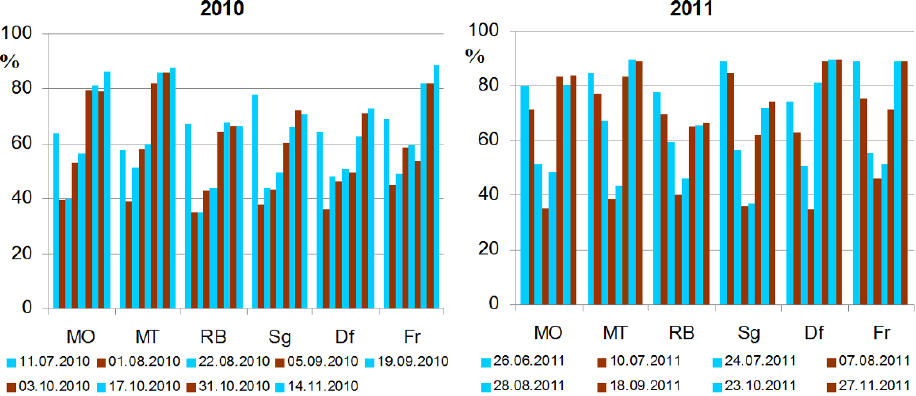
Figure 6. Percentage of content of tartaric acid from the total content of titratable acids in grape juice of individual studied grapevine varieties in 2010 and 2011: Muscat Ottonel (MO), Müller-Thurgau (MT), Pinot Blanc (RB), Sauvignon (Sg), Dornfelder (Df), and blue Frankish